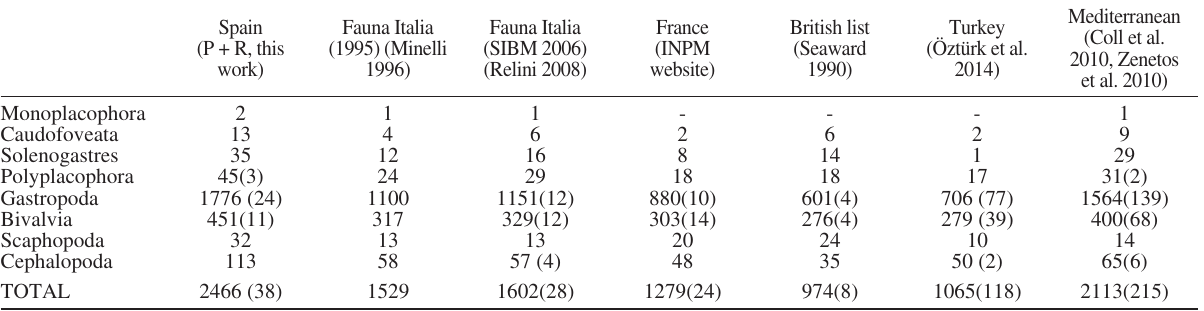
Table 7. – Number of species representing each Class of the Mollusca in several European and Mediterranean countries. The numbers in bracket are those of species reported as non-indigenous. Spain (P + R,